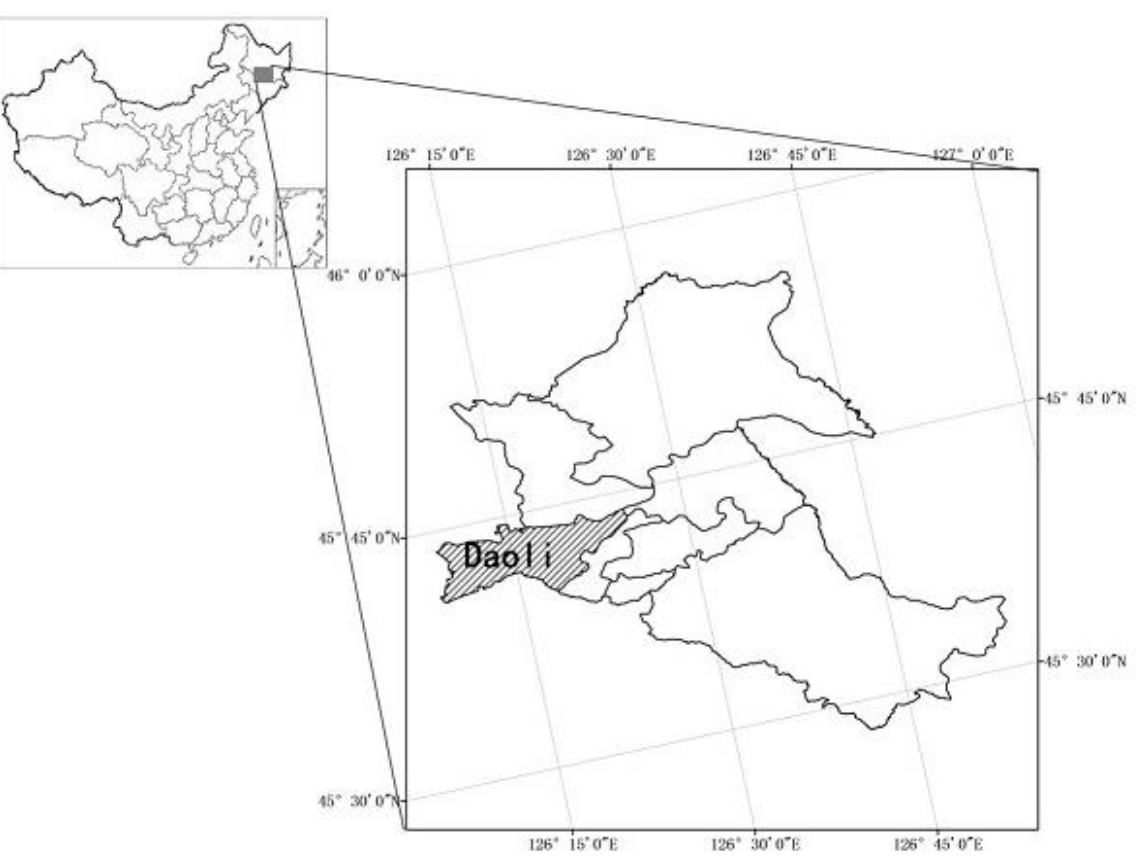
Figure 1. Geographical location of the study